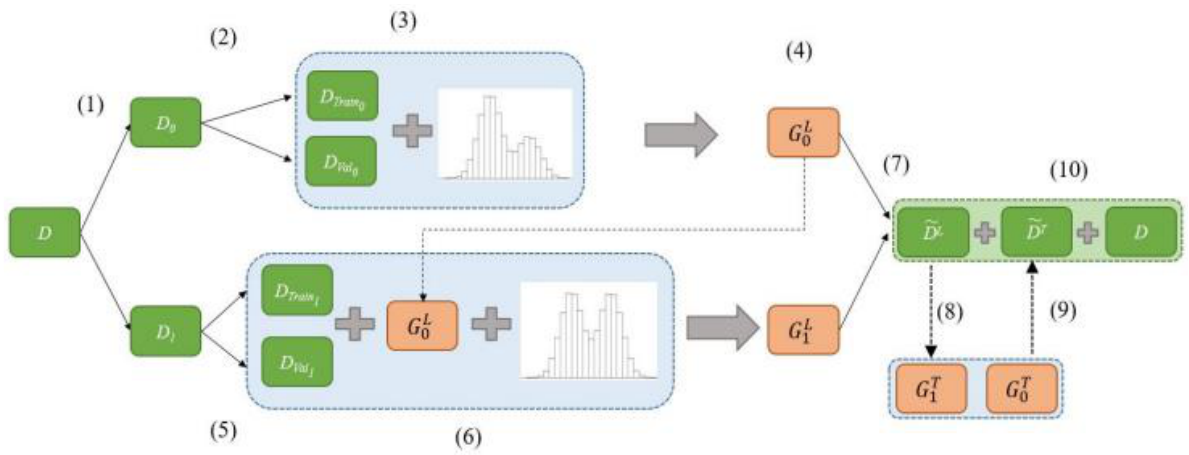
Figure 3. The majority – minority GAN framework.